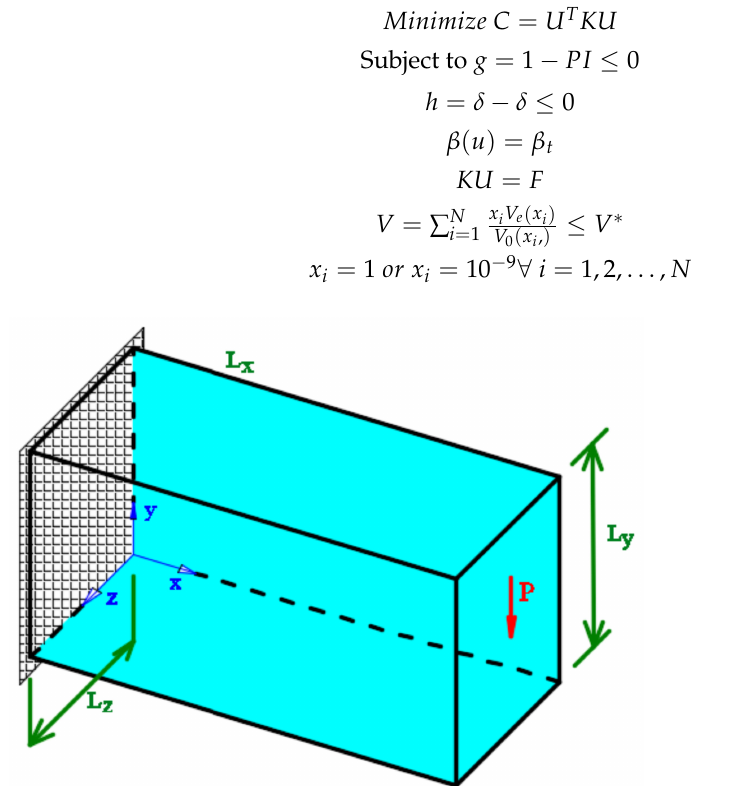
Figure 4. Design